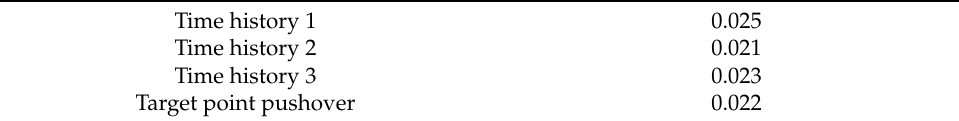
Table 17. Maximum S d (m) for case study 6. Table 18. Ductility request for case study 6.